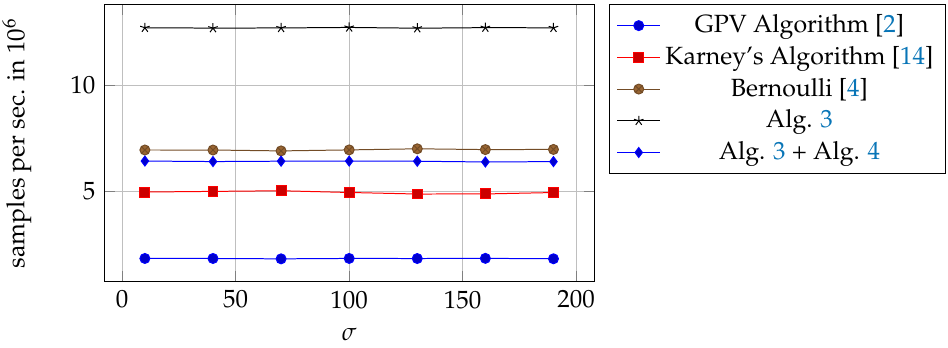
Figure 1. Performance Comparison of Sampling